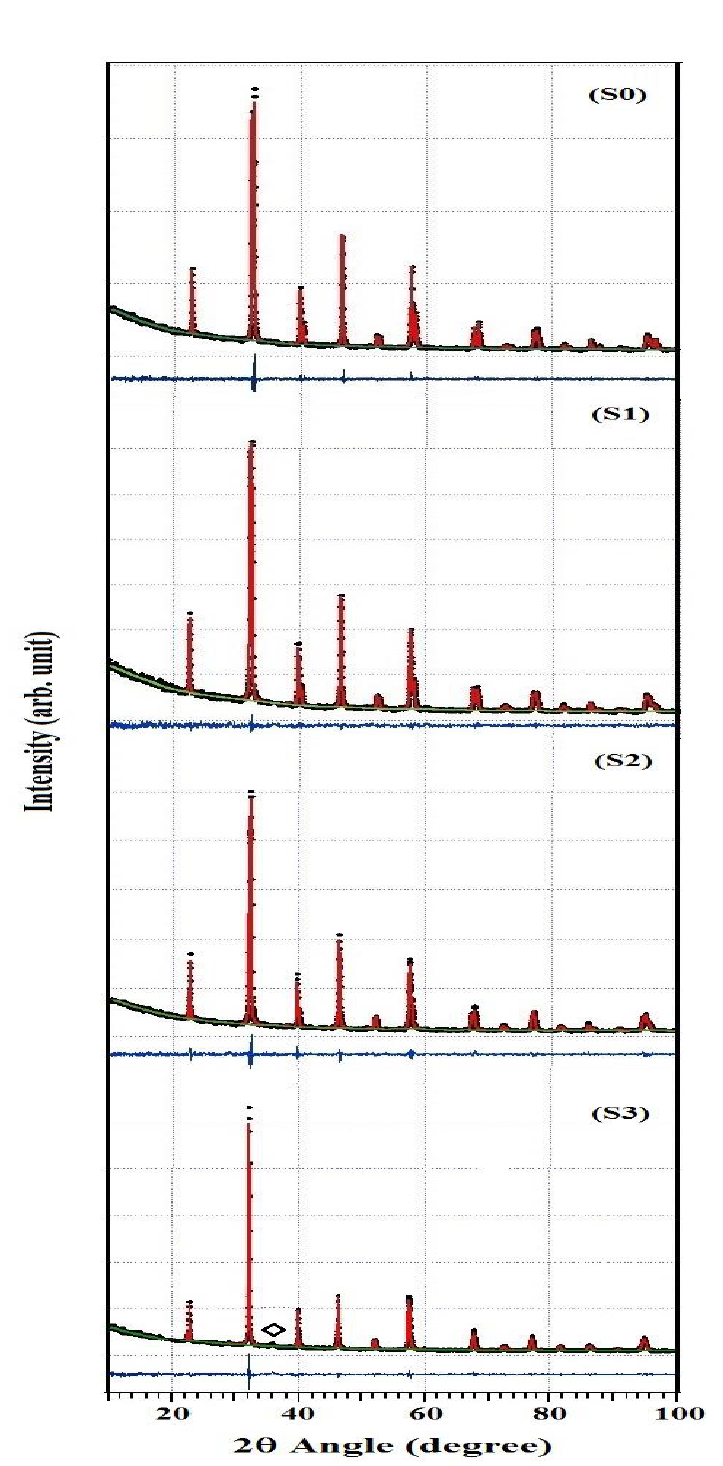
Figure 1. The X-ray diffraction pattern of LaMnO 3 (S0), La 0.9 Ba 0.1 MnO 3 (S1), La 0.8 Ba 0.2 MnO 3 (S2), and La 0.7 Ba 0.3 MnO 3